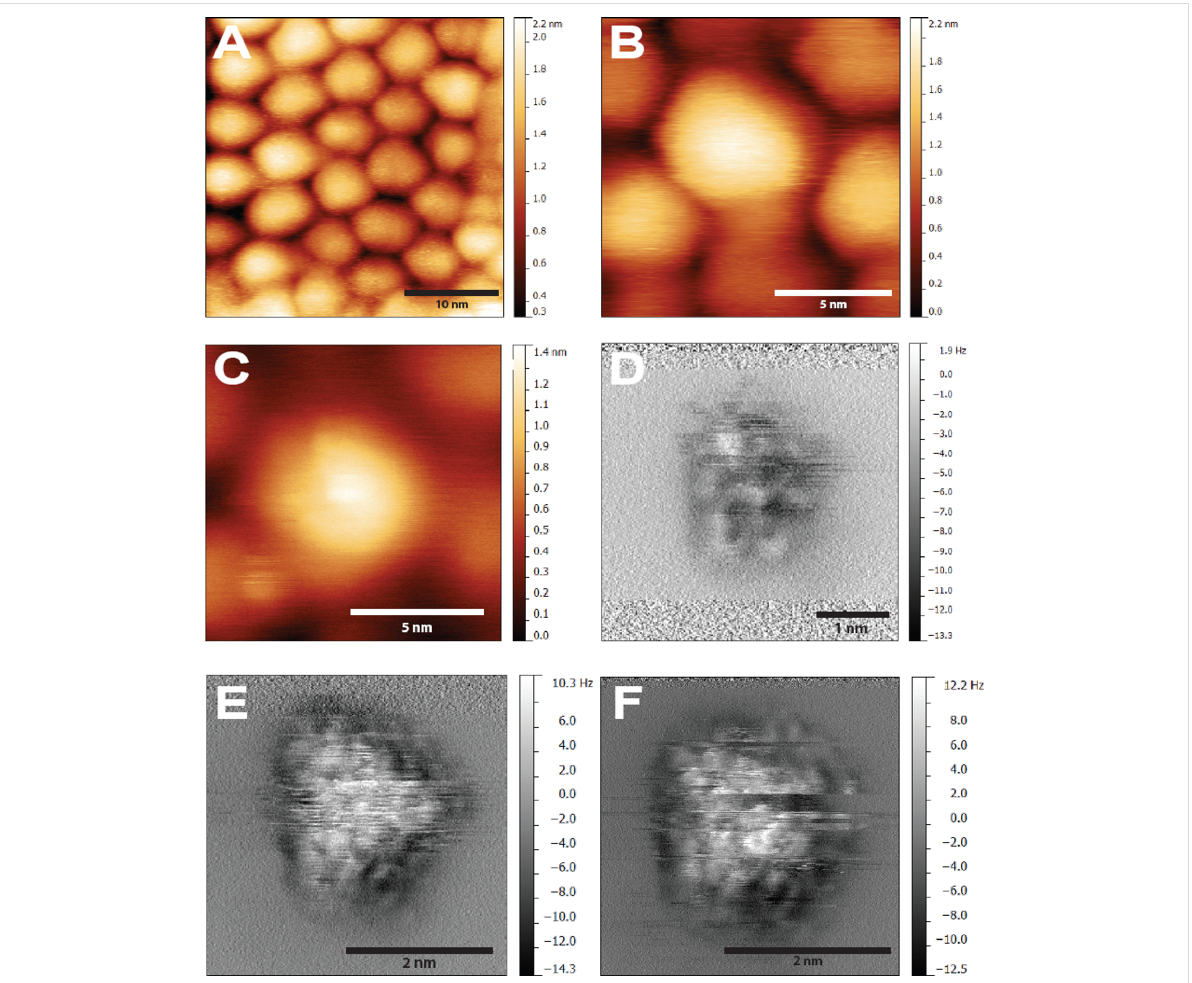
Figure 1: (A) Overview dSTM image showing packing of nanocrystals in a supracrystal. V gap = +2.5 V, = 20 pA, A 0 = 1 nm. (B) High resolution dSTM image of nanocrystals. V gap = +1.5 V, = 10 pA, A 0 = 0.11 nm. (C) Constant frequency shift DFM image of same region V gap = 0 V, Δ f = − 2 Hz, A 0 = 0.11 nm. (D) Constant height image of nearby region. Estimated height relative to feedback position Δ z = − 0.2 nm. (E)